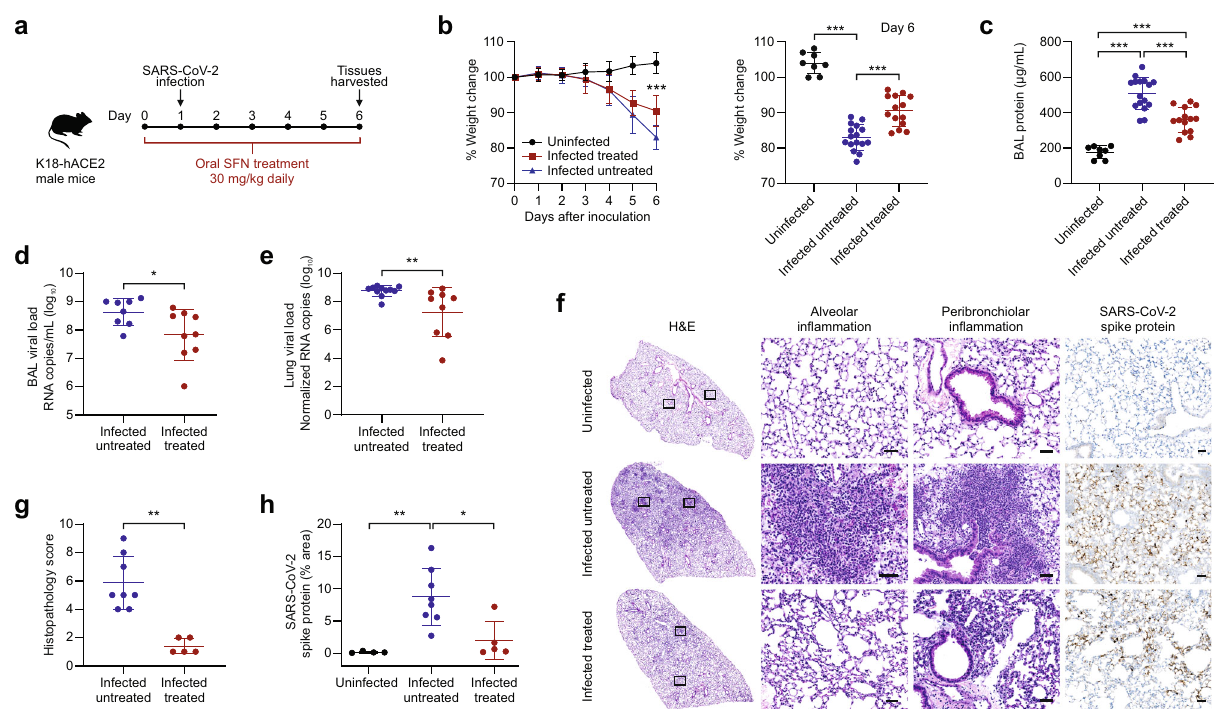
Fig. 3 SFN treatment in SARS-CoV-2 infected K18-hACE2 mice. a Six- to eight-week-old male K18-hACE-transgenic mice were randomly distributed among treatment groups and inoculated intranasally with SARS-CoV-2/USA/WA1/2020 or vehicle. b Four days post inoculation, there was a marked weight loss in the infected groups, although there was signi fi cantly less weight loss in the SFN treated animals. By day 6 post inoculation, the SFN-treated animals had lost 7.5% less bodyweight compared to infected untreated controls (one-way ANOVA, *** P < 0.0001). Data from three independent experiments, uninfected ( n = 8), infected untreated ( n = 16), infected treated ( n = 14). c Bronchoalveolar lavage (BAL) total protein quanti fi cation, determined as a surrogate for lung injury, measured 6 days post-infection. Infected untreated animals had signi fi cantly higher total protein compared to the infected treated group (one-way ANOVA, *** P < 0.0001). Data from three independent experiments, uninfected ( n = 8), infected untreated ( n = 16), infected treated ( n = 14). d The viral load in the BAL, as determined by qPCR, was signi fi cantly higher in infected untreated animals compared to the infected treated group (Mann – Whitney U test, two-tailed, * P = 0.036). Data from two independent experiments, infected untreated ( n = 8), infected treated ( n = 9). e The viral load in the lungs of infected treated animals, represented as the SARS-CoV-2 N protein copies normalized to Pol2Ra , had a 1.5 log 10 reduction compared to infected untreated controls (Mann – Whitney U test, two-tailed, ** P = 0.004). Data from two independent experiments, infected untreated ( n = 11), infected treated ( n = 9). f Hematoxylin and eosin (H&E) staining and immunostaining for SARS-CoV-2 spike protein of histological sections of the lungs of representative uninfected control, infected untreated and infected treated mice. Regions of the lung anatomy where alveolar and peribronchiolar in fl ammation was assessed are highlighted in boxes. Images show low (left panels; scale bar, 1 mm) and high-power magni fi cation (right panels; scale bar, 50 µ m) of the same tissue section. g Histopathological severity scoring was evaluated according to the pathological changes outlined in the methods section. Data from one independent experiment, infected untreated ( n = 8), infected treated ( n = 5). Mann – Whitney U test, two-tailed, ** P = 0.0008. h Quanti fi cation of the SARS-CoV-2 spike protein immunostaining showed a 4.41× lower % area in the lungs of SFN-treated mice compared to infected untreated controls ( P = 0.01). Data from one independent experiment, uninfected ( n = 4), infected untreated ( n = 8), infected treated ( n = 5). One-way ANOVA, * P < 0.05, ** P < 0.005. All the data in this fi gure are represented as mean ± standard deviation. Each dot